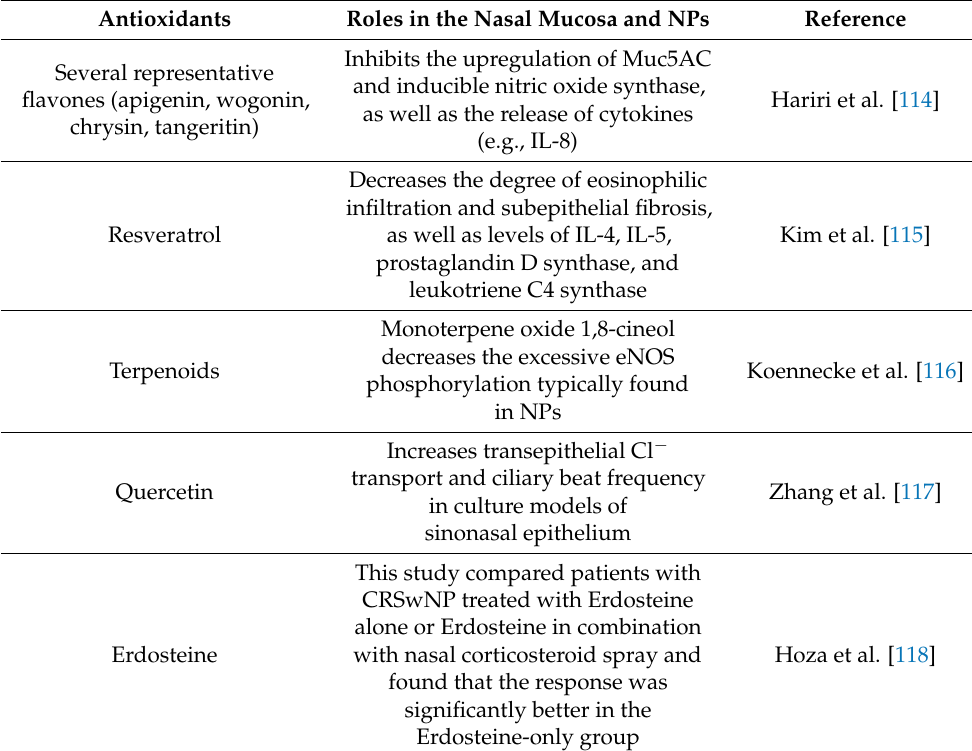
Table 5. Potential antioxidants for use in the treatment of